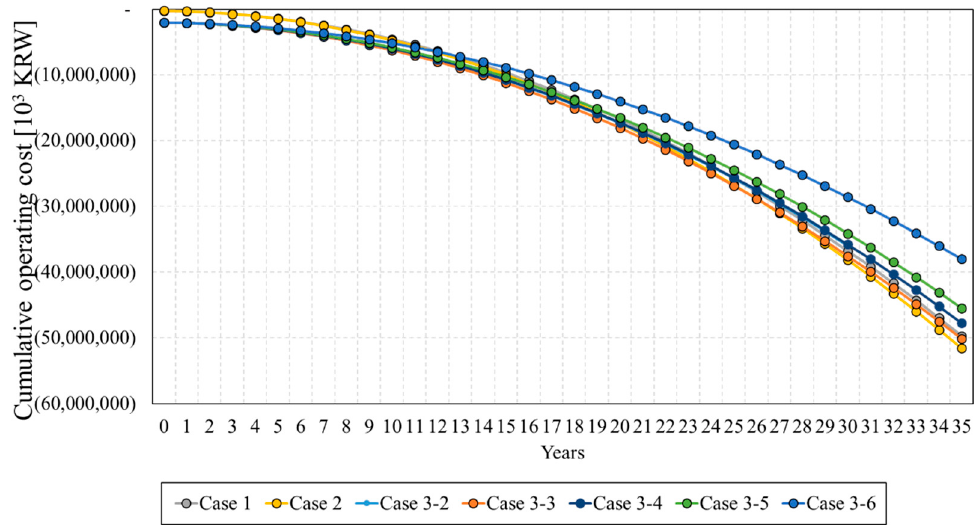
Figure 11. Cumulative operating cost.